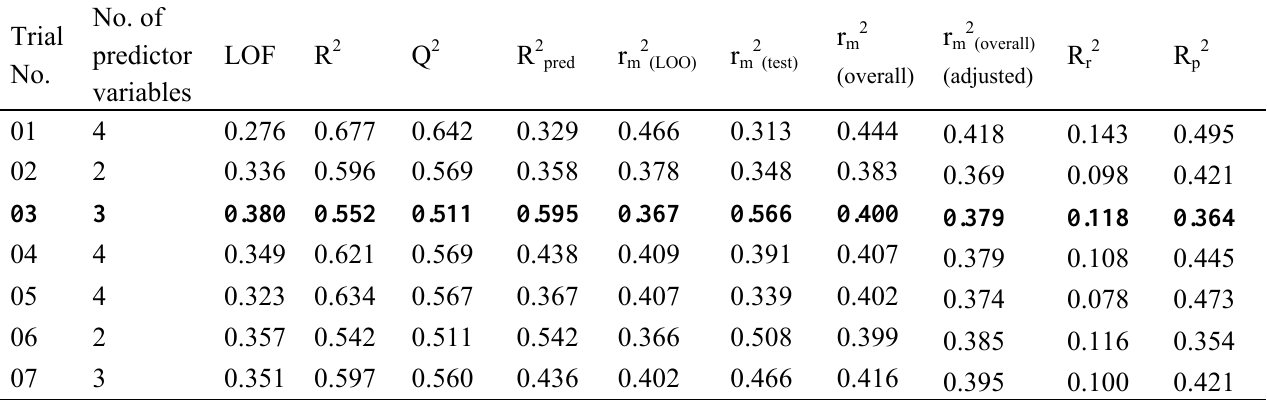
Table 4. Comparison of statistical qualities and validation parameters of different models (Data set I).